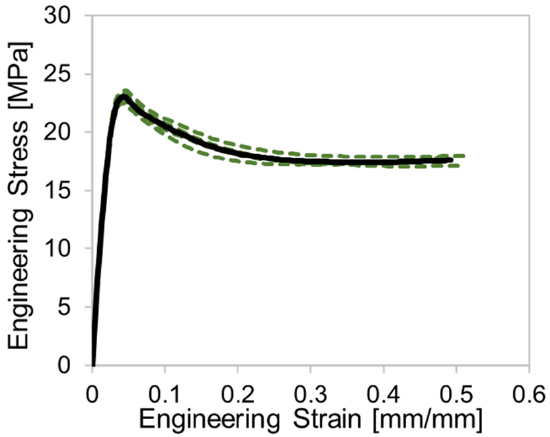
Figure 2. The stress–strain curves for the calculated average (black curve) and individual repeat tests (dashed green curves) for Resin 2 with a 30 min cure time.